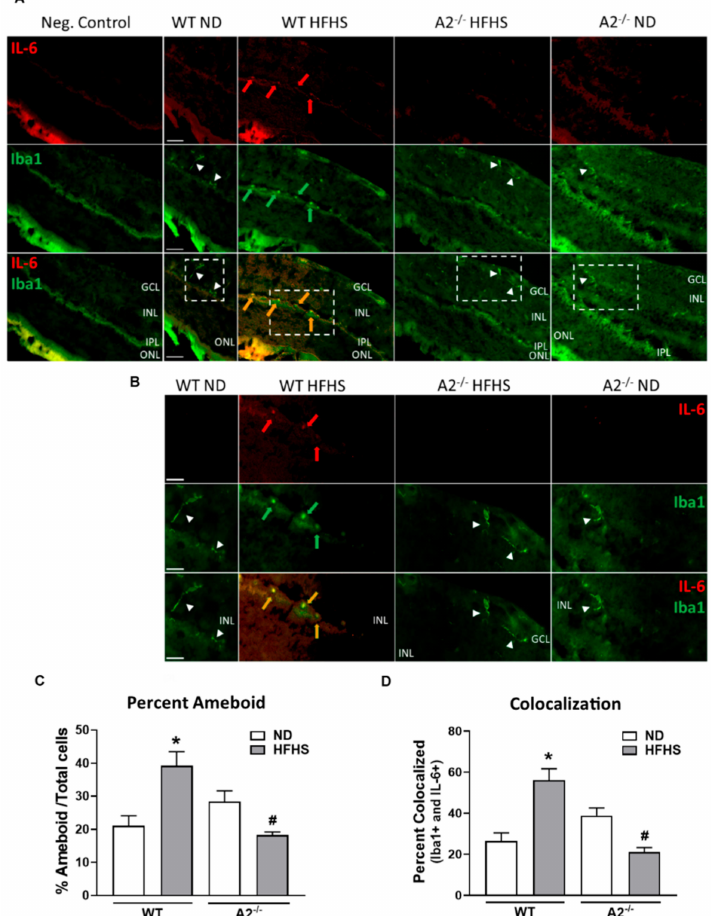
Figure 4. Arginase 2 (A2) deletion prevented high-fat, high-sucrose (HFHS)-induced retinal microglia activation / pro-inflammatory macrophage infiltration. Representative images at 20 × ( A ) and 40 × ( B ) showing immunofluorescent double-labeling of the inflammatory marker, interleukin-6 (IL-6) (red) and microglia / macrophage marker, ionized calcium binding adaptor molecule 1 (Iba1) (green), in retina sections of wild-type (WT) and A2 − / − mice fed a normal diet (ND) or HFHS diet ( n = 5 per group). Boxes with dashed lines on 20 × images illustrate the same section imaged at 40 × shown below ( B ). Red arrows point to regions of IL-6 expression, green arrows point to ameboid microglia / macrophages, and orange arrows point to co-localization of IL-6 and Iba1 (yellow) in ameboid microglia or infiltrating inflammatory macrophages. White arrow heads point to ramified resident microglia.